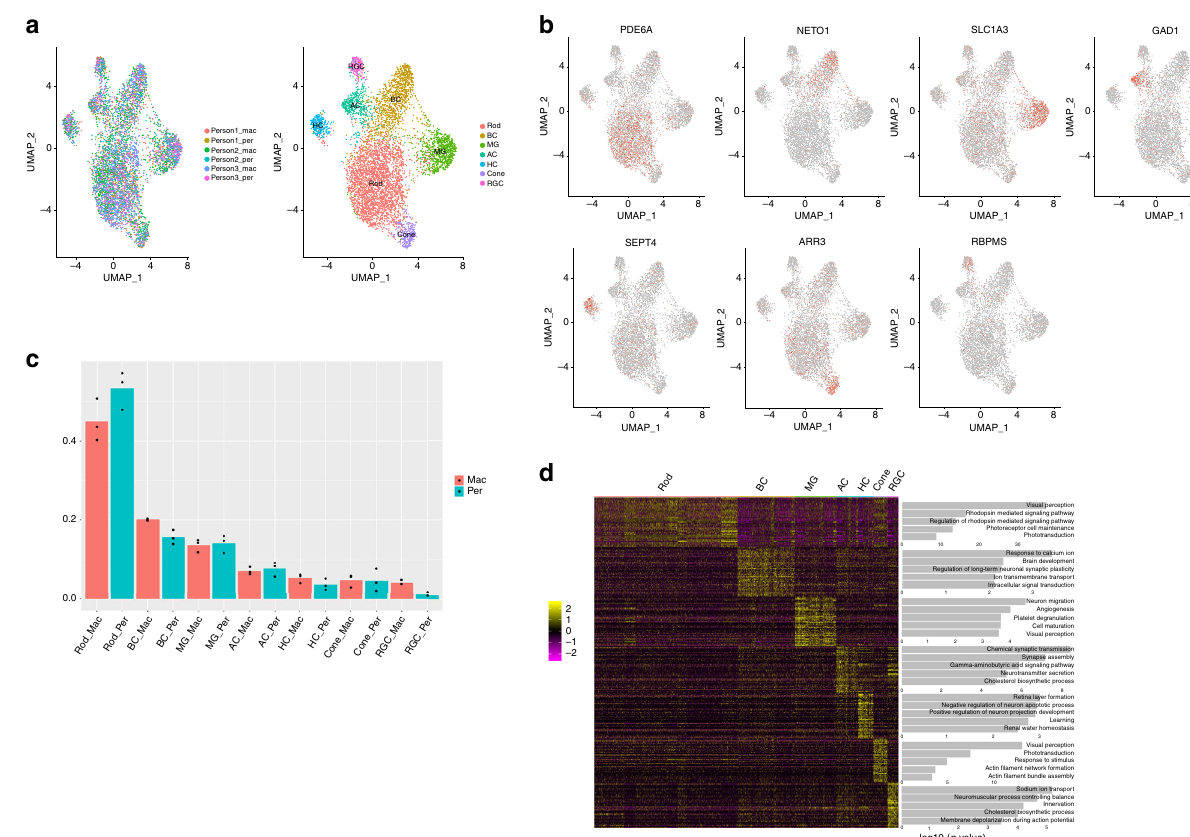
Fig. 2 Unsupervised clustering identi fi es seven major cell types in the human retina. a Clustering of 5873 human retina single-nuclei expression pro fi les into seven populations (right) and representation of the alignment of six datasets from three donors (left). b Pro fi les of known markers ( PDE6A, NETO1, SLC1A3, GAD1, SEPT4, ARR3, RBPMS ) in each cluster. c The proportion of the seven cell types (rod, BC, MG, AC, HC, cone, RGC) in the macular and peripheral samples (bar graph shows the mean of the proportion; single data points are visualized in dots, N = 3). d Heatmap of DEGs in each cell type and the gene ontology term enrichment by each set of DEGs. For visualization, top 50 DEGs with least FDR q-value and top fi ve terms under the biological process category with least p -value were used. Each column represents a cell while each row represents a gene. Gene expression values are scaled across all the cells.